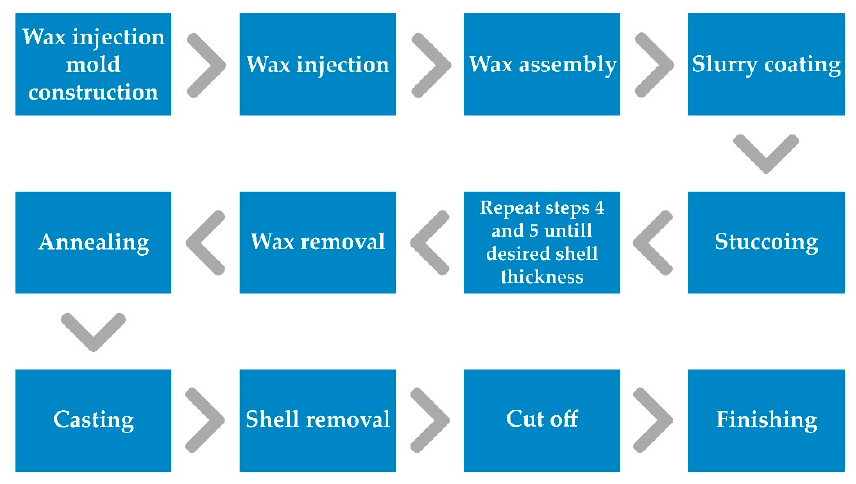
Figure 1. The block diagram of the investment casting process.